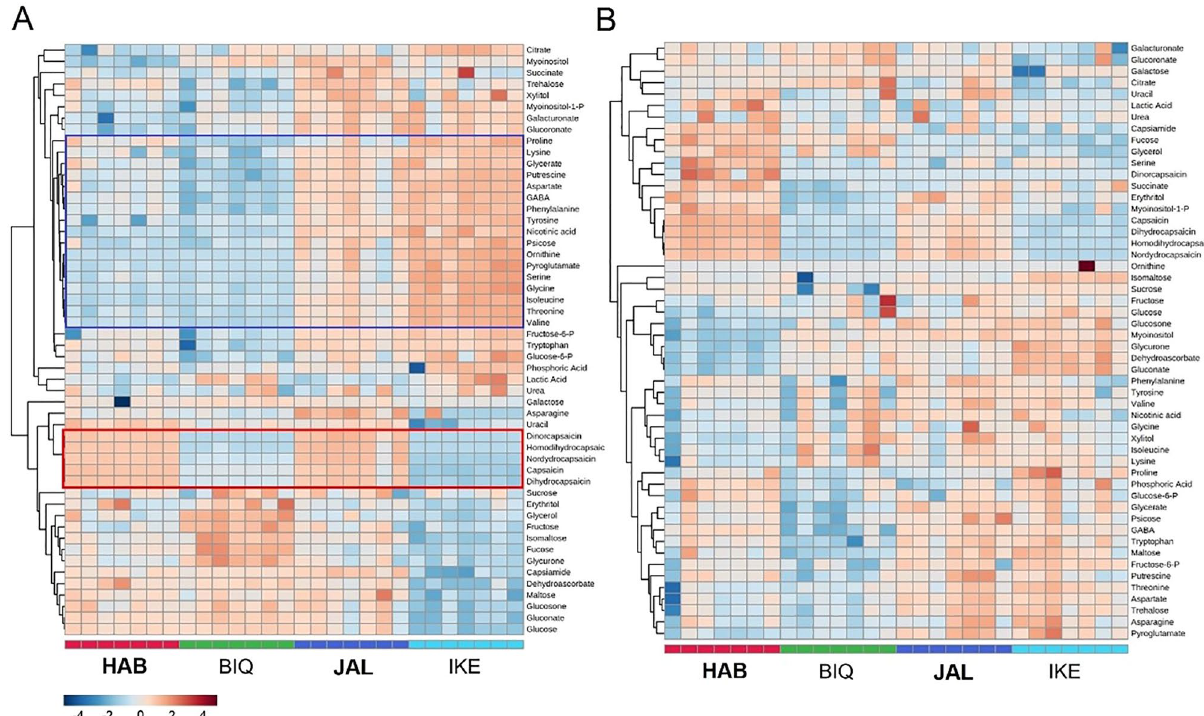
Figure 1. Hierarchical clustering and heat map of primary metabolites in ( A ) the fruit placenta (PLA) and ( B ) pericarp (PER) of C. chinense cv. Habanero (HAB), C. chinense cv. Biquinho (BIQ), C. annuum cv. Jalapeño (JAL) and C. annuum cv. Cascadura Ikeda (IKE). The pungent genotypes are shown in boldface. Each column represents a genotype, the seven subdivisions within each column represent individual plants (n = 7). Rows represent traits. The color key indicates the relative trait value normalized by glog transformation and autoscaled (mean-centered and divided by the standard deviation of each variable). In the placenta all capsaicinoids cluster together (highlighted in red) and most amino acids cluster together (highlighted in